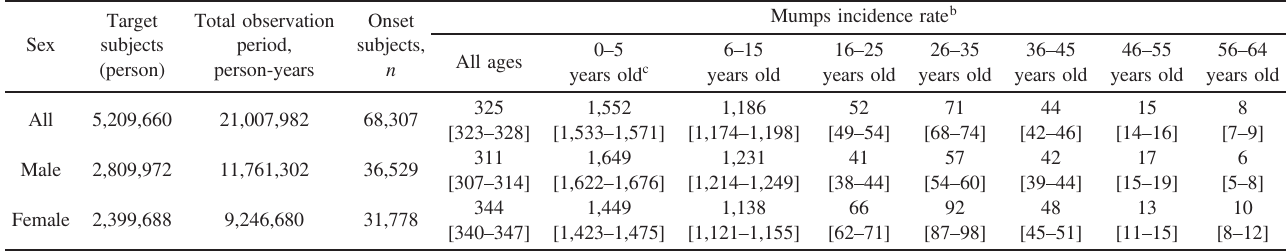
Table 2. Overall mumps incidence rate [95% CI] during the study period in males and females (0 – 64 years old) in a JMDC database cohort, according to age and sex groups a